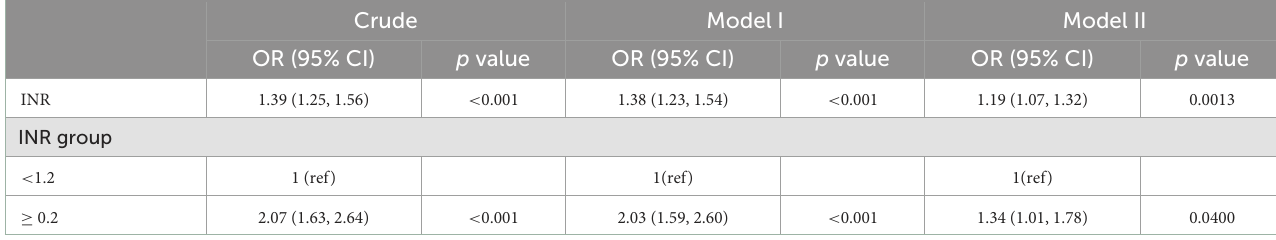
TABLE 5 The logistics regression analyses of INR for predicting 1-year all-cause mortality of post-CA patients in validation cohort.